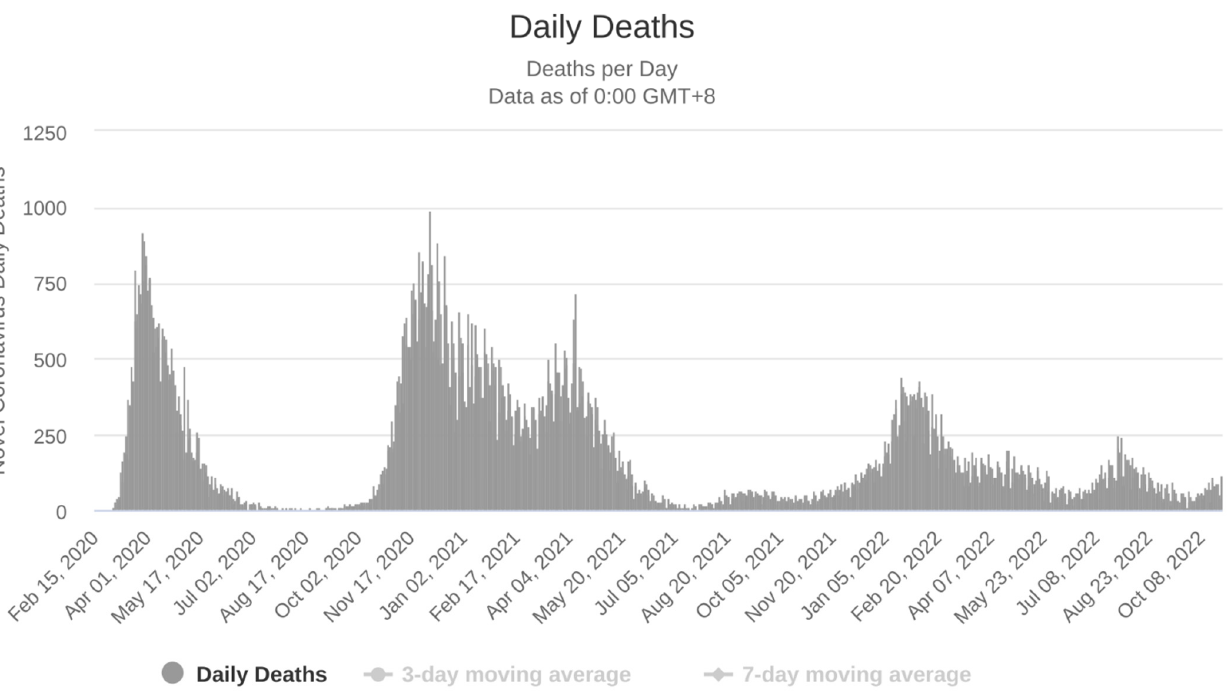
Figure 7. COVID-19 trends in deaths in Italy.